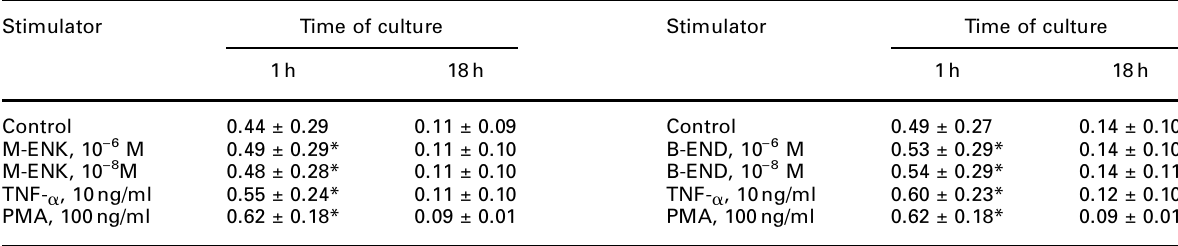
Table 1. The effect of opioid peptides on MTT reduction in vitro Stimulator